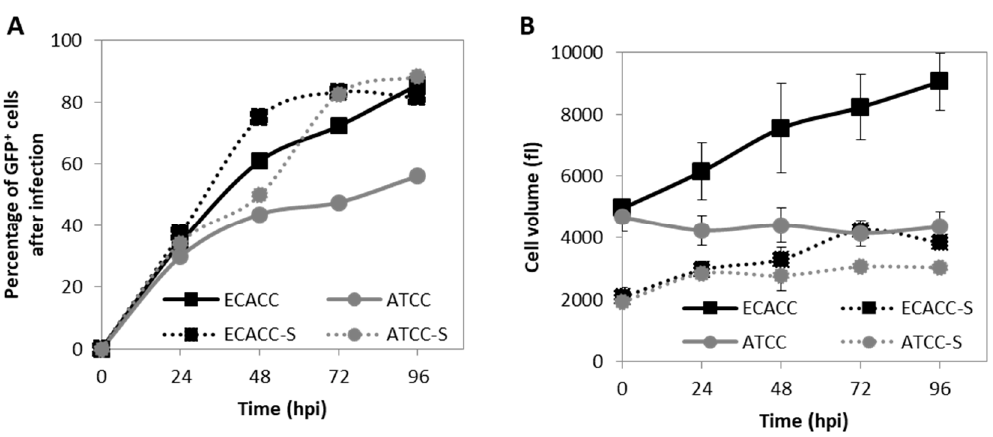
Figure 5. Progression of infection of CAV-2 in MDCK cells from ATCC and ECACC in static monolayer (solid lines) and agitated suspension cultures (S, dotted lines). ( A ) Progression of infection was monitored during the production of CAV-pIX-GFP, a replicative-competent CAV-2, by quantifying the percentage of GFP-positive (GFP + ) cells by flow cytometric analysis over time. At each time point, parallel non-infected cultures of each the corresponding cells were used as gating controls (see Figure A5, Appendix A, Supplementary Materials for further details). Since CAV-pIX-GFP has a GFP fused to the pIX (capsid protein), GFP expression was used as an indicator of late phase viral protein expression. Values are shown as average (n between 2 and 5) and error bars were omitted for simplicity and visualization clearness. ( B ) Volume of MDCK cells during infection with CAV-pIX-GFP. Adherent cultures were infected at MOI 5 and suspension cultures at MOI 1. Values are shown as average ± standard deviation ( n = 3).